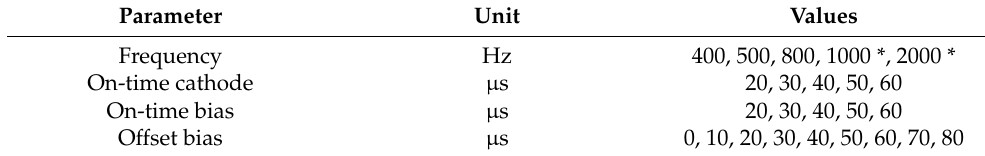
Table 1. Overview of the high-power impulse magnetron sputtering (HiPIMS) parameters